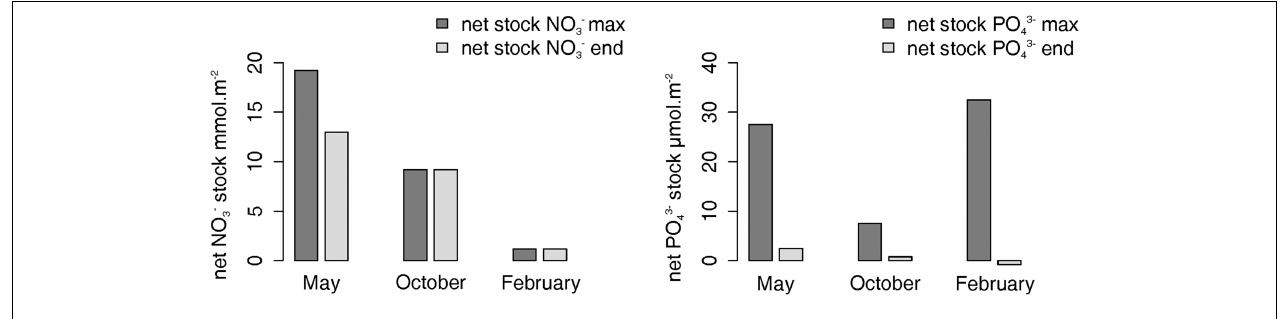
FIGURE 3 | Mean integrated [NO − 3 ] in mmol m − 2 (left) and mean integrated [PO 3 − 4 ] in μ mol m − 2 (right) over minicosm in May, October, and February. The dark gray bar represents the maximum change in NO − 3